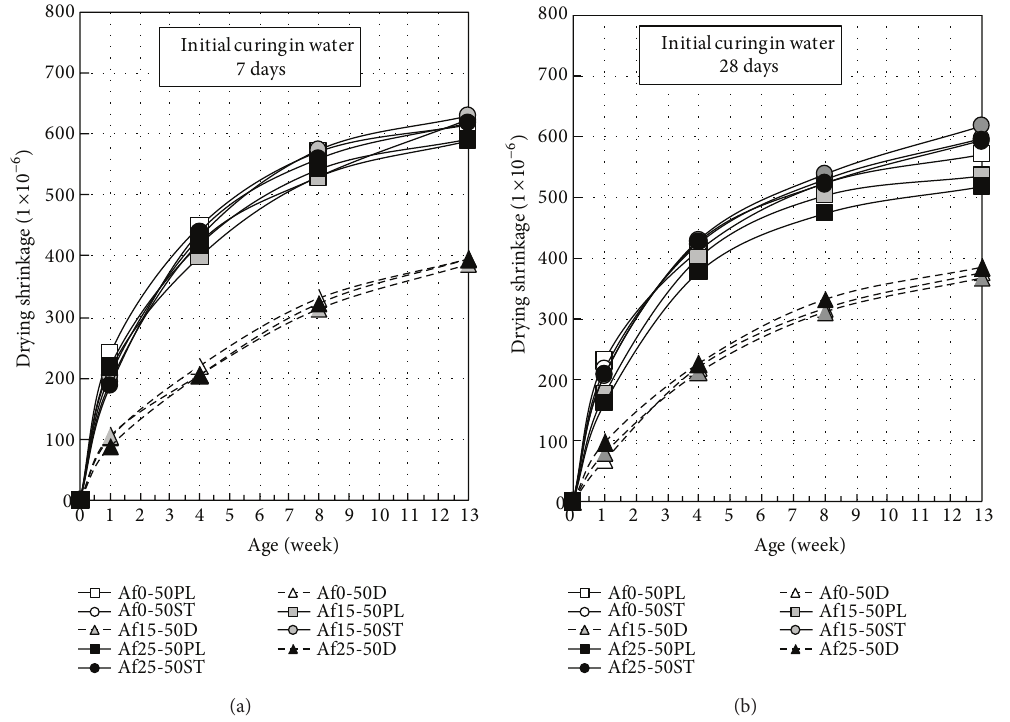
Figure 6: Change in length of concrete in 50% water-binder ratio.